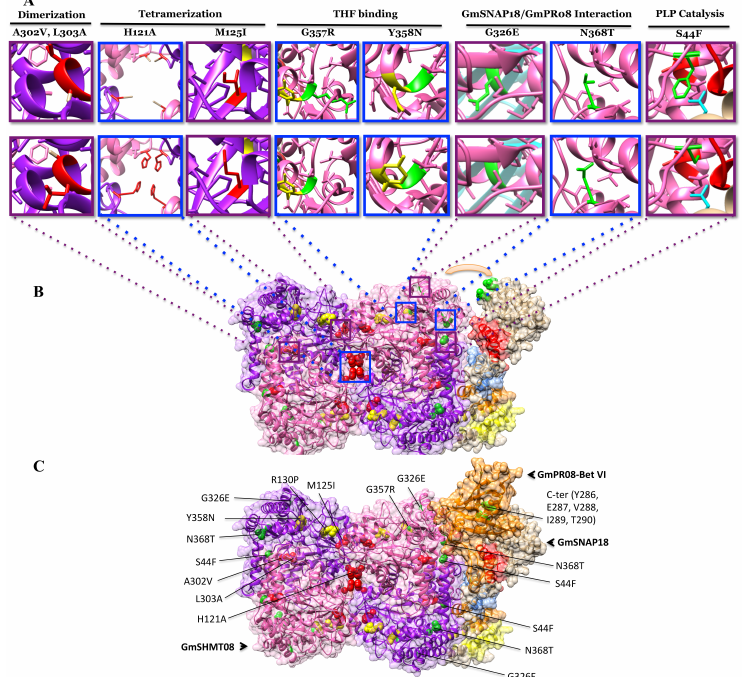
Figure 4. Mutational analysis supports the GmSNAP18 / GmSHMT08 / GmP08-Bet VI multi-protein complex predicted model. ( A ) The nine Gmshmt08 mutant alleles used in the mutational analysis to study the predicted homology model (multi-protein). (down panel) represents the original residues in the Forrest WT, (up panel) represents the mutated residues (Induced and natural occurring mutations). ( B ) The predicted interaction between GmSHMT08 (left) and GmSNAP18 (Right). The surface in the middle (orange arc) correspond to the pocket where GmPR08-Bet VI protein was predicted to fit. Locations of the four TPR motifs (TPR1: Yellow, TPR2: Orange, TPR3: Blue, TPR4: Red) and polymorphisms (Green) at the GmSNAP18 are shown (Right). ( C ) The predicted interaction between GmSNAP18, GmSHMT08, and GmPR08-Bet VI protein complex. GmSHMT08 EMS induced mutations a ff ecting Dimerization (red), Tetramerization (red), and Interaction (Green) with GmSNAP18 and GmPR08-Bet VI proteins are shown. The two polymorphisms R130P and Y358N between Essex and Forrest are shown in yellow. The GmSHMT08 EMS mutant M125I